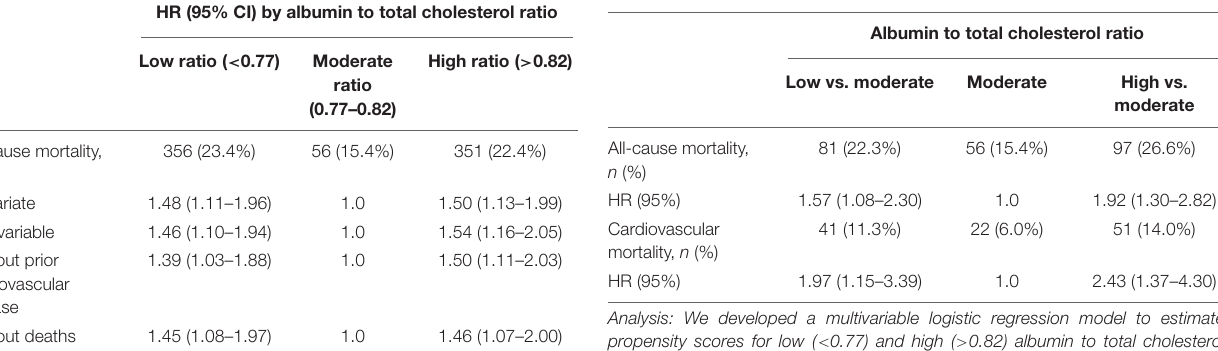
TABLE 5 | Propensity score-based matched analysis for comparison of low to moderate albumin to total cholesterol ratio and high to moderate albumin to total cholesterol